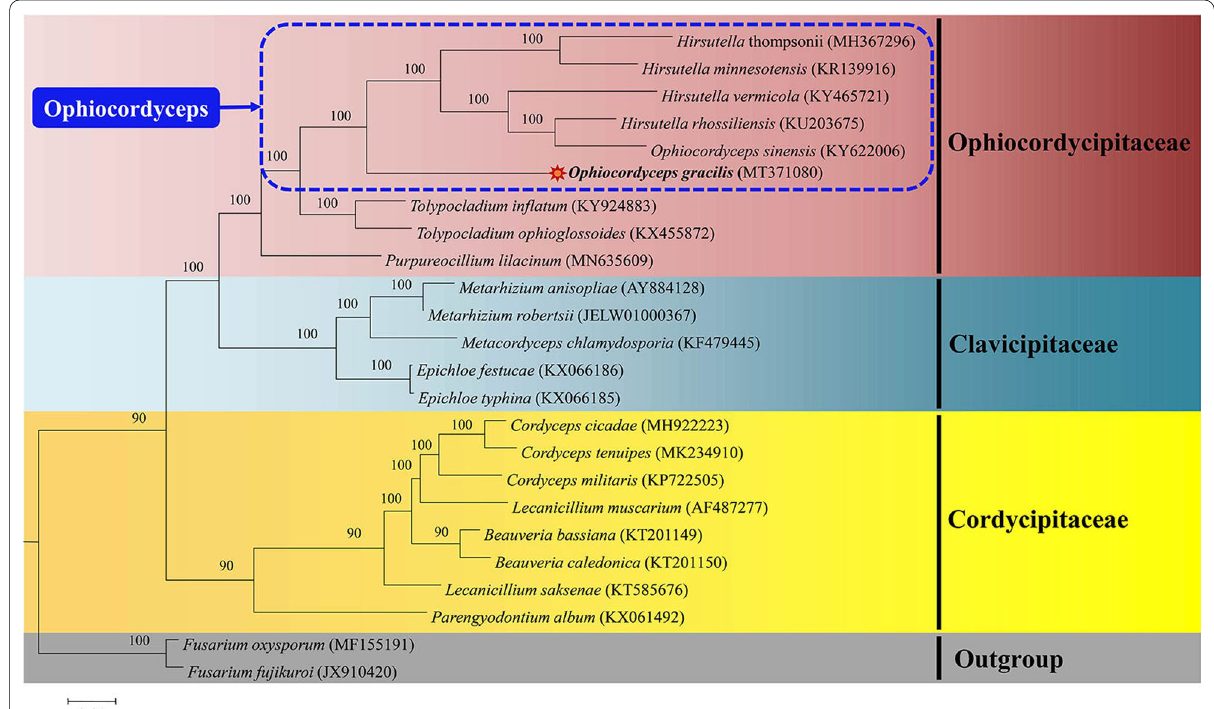
Fig. 6 Phylogenetic relationships of Ophiocordyceps gracilis and 23 other taxa of Hypocreales inferred from mitogenomes based on the Bayesian inference. Ophiocordyceps is framed with a dotted blue line. The species and GenBank accession number for mitogenomes used in the phylogenetic analysis are provided in Additional file 10: Table